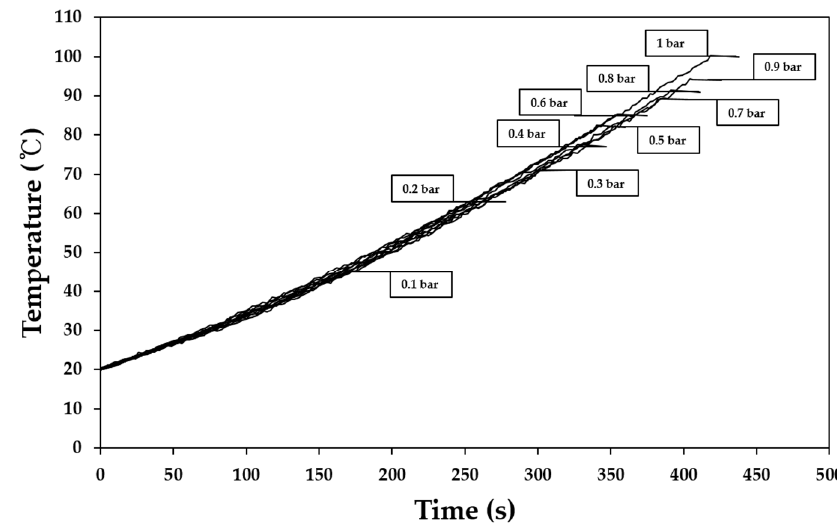
Figure 5. Change of boiling point of base solution under different vacuum intensities.